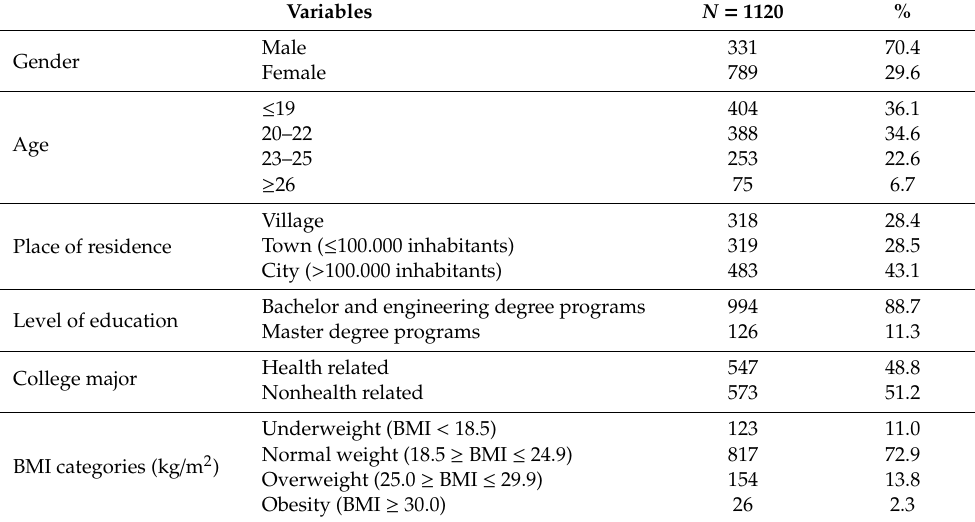
Table 2. Sociodemographic characteristics of